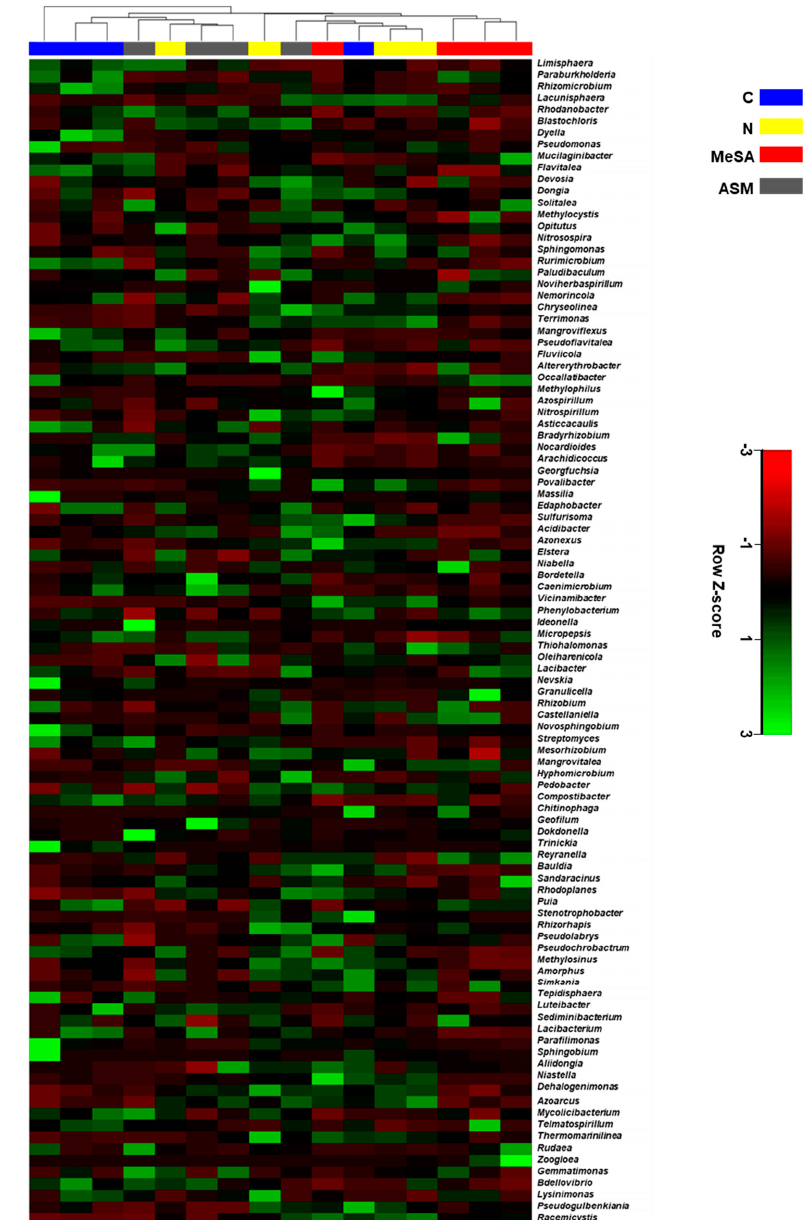
Figure 6. Heatmap of the average linkage hierarchical clustering, based on the Manhattan distance measurement of dominant 100 bacterial genera in the rhizosphere of pine seedlings. C, negative control; N, nematode-inoculated; MeSA, nematode-inoculated pine seedlings treated with methyl salicylic acid; ASM, nematode-inoculated pine seedlings treated with acibenzolar-s-methyl. The Z-Score indicates the relative abundance of bacterial genera in each row following heatmap standardization.